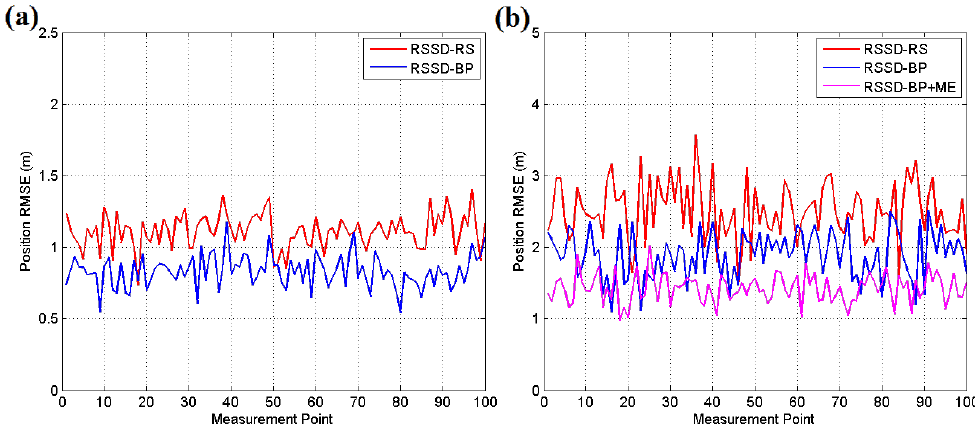
Figure 15. ( a ) RMSE of the still target for each testing position in scene 1; ( b ) RMSE of the moving target for each testing position in scenario 1.